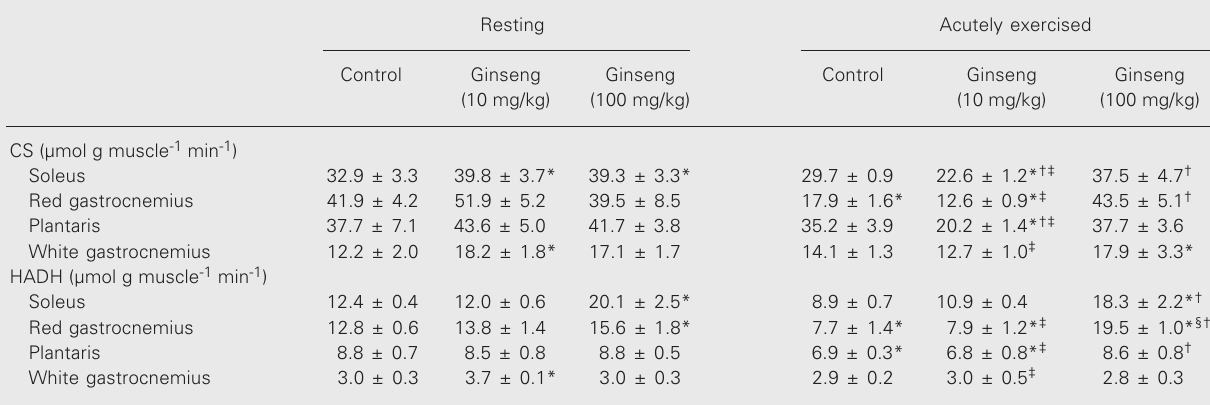
Table 1. Oxidative enzyme activities of citrate synthase and 3-hydroxyacyl-CoA dehydrogenase in skeletal muscle of rats treated with ginseng extract. Resting Acutely